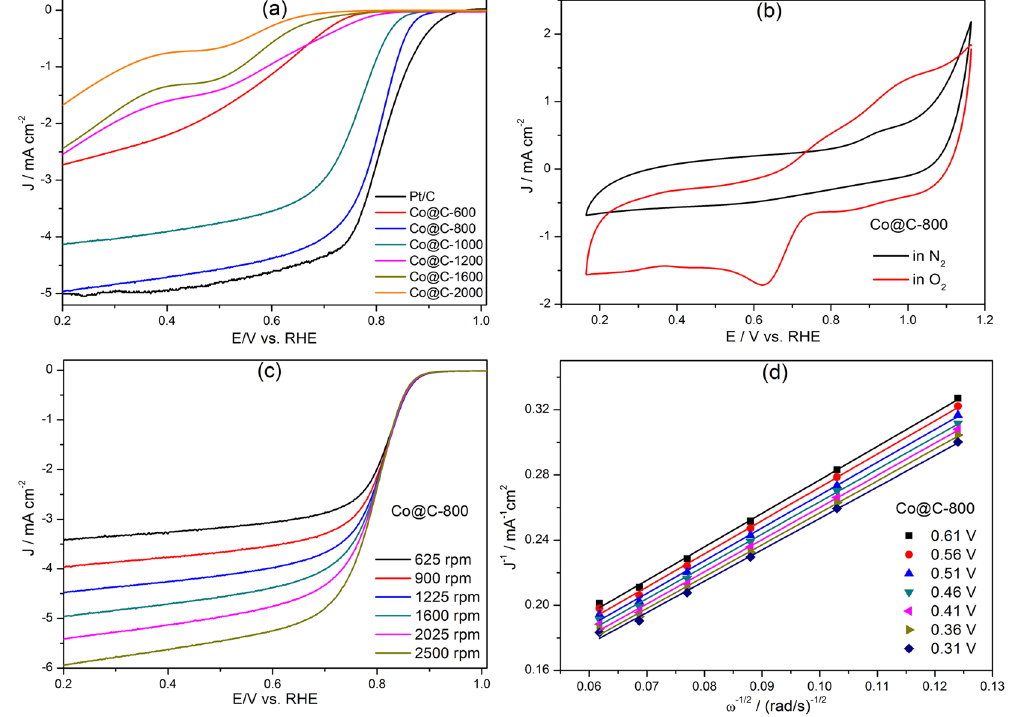
Figure 5. ( a ) LSV curves of the as-synthesized Co@C composites and Pt/C at 1600 rpm. ( b ) CV curves of Co@C-800. ( c ) Polarization curves of Co@C-800 measured at different rotation speeds. ( d ) K-L plots of Co@C- 800 at different potentials.